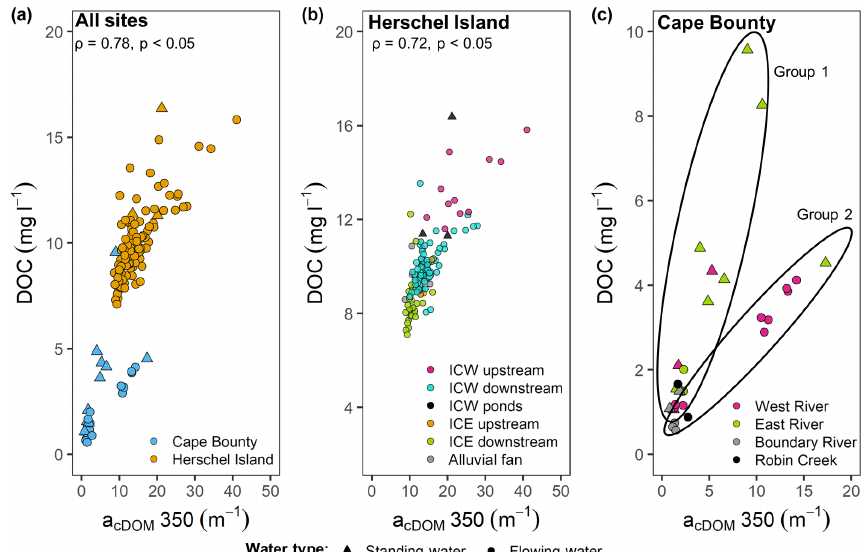
Figure 3. Absorption of coloured dissolved organic matter (cDOM) at 350nm (m − 1 ) versus dissolved organic carbon (DOC) concentration (mgL − 1 ) for (a) all sites; (b) sites on Herschel Island depicting the sampling locations Ice Creek West (ICW) upstream, downstream, and ponds; Ice Creek East (ICE) upstream, downstream, and alluvial fan; and (c) sites at Cape Bounty (West River, East River, Boundary River, Robin Creek). Note that flowing water is indicated by a circle while standing water such as lakes or ponds is indicated by a triangle. The cDOM-to-DOC relationships are divided into two different groups (c) .